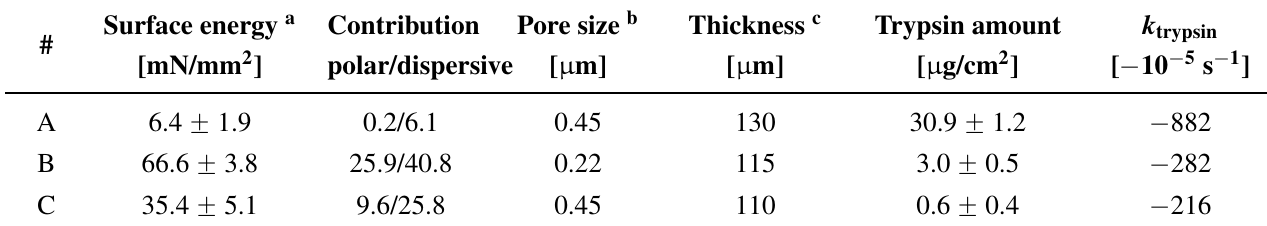
Table 1. Characteristics of three different biocatalytic trypsin/polyvinylidene fluoride (PVDF) membranes.